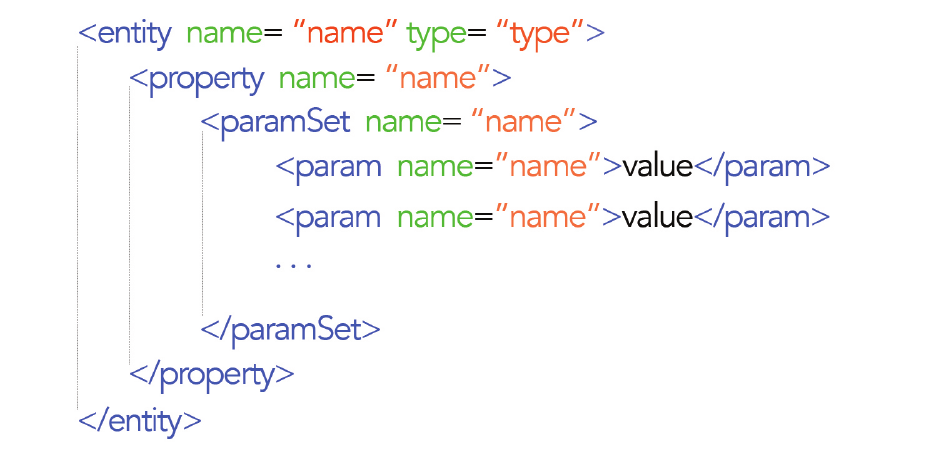
Figure 2. XML entity’s